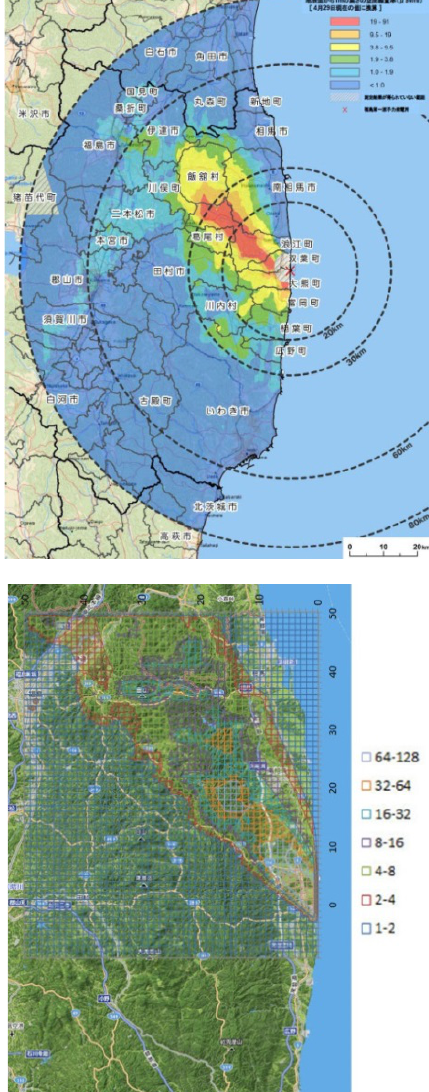
Figure 12. Actual pollution map by aircraft monitoring (upper) and synthesized radioisotope pollutions with altitude correction (lower). (Unit: μ